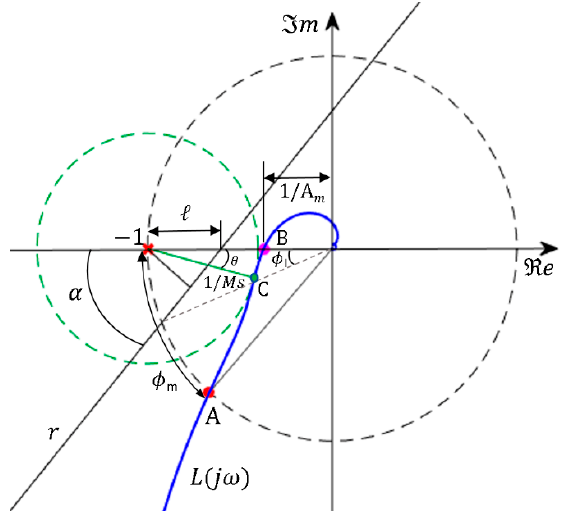
Figure 3. Robustness margins in the Nyquist diagram.